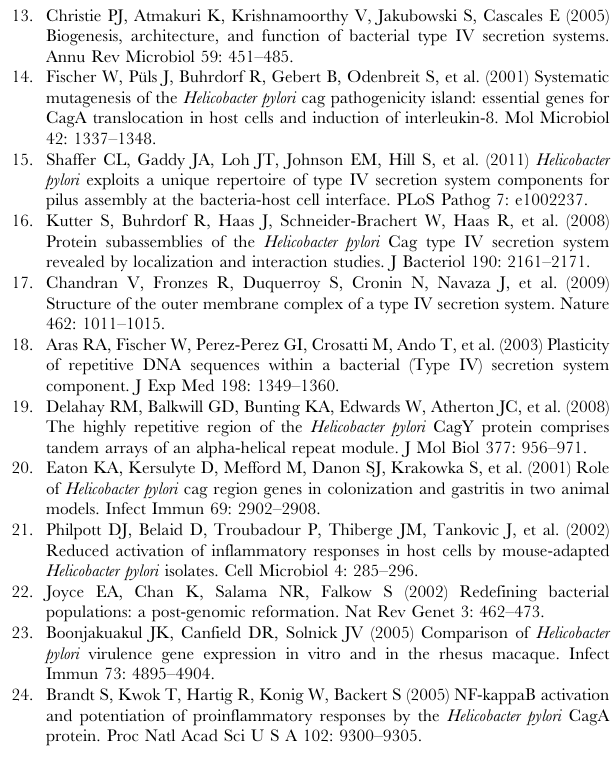
Figure S7 Persistence in one monkey of a variant cagY strain that induces IL-8, related to Figure 10. Monkey 36001 was inoculated with mOut2, which has a variant cagY allele and does not induce IL-8 or phosphorylate CagA. Repeated sampling of monkey 36001 up to 24 wks PI showed that all output colonies recovered 8 wks or more PI induced IL-8 and expressed a cagY that differed from that in mOut2. Table S1 Quantitative analysis of H. pylori pili by FEG- SEM. Table S2 Bacterial strains and plasmids. Table S3 DNA primers used for PCR (bold) and